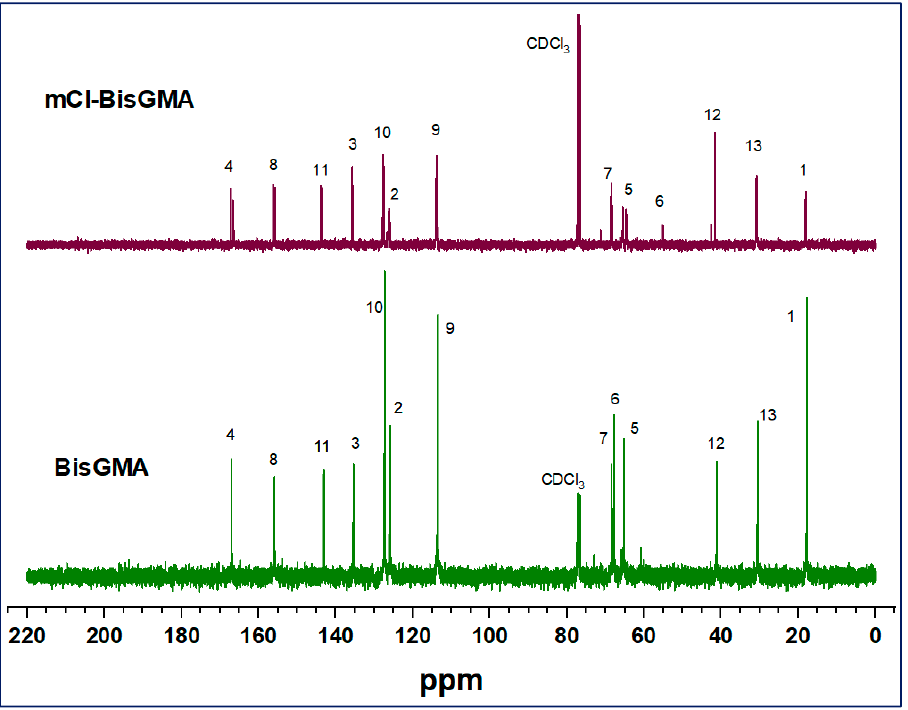
Figure 4. 13 C-NMR spectra of BisGMA and mCl-BisGMA in CDCl 3 . Peaks numbered in positions similar to those illustrated in 1 H-NMR spectra.